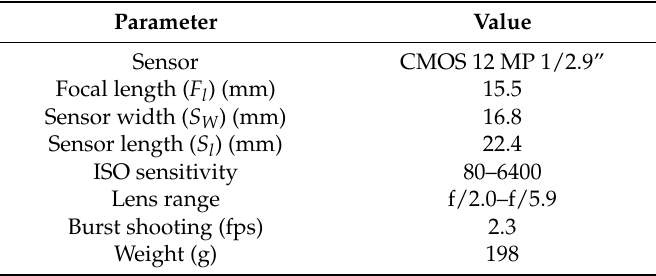
Table 2. GoPro Hero 4 Black Edition.